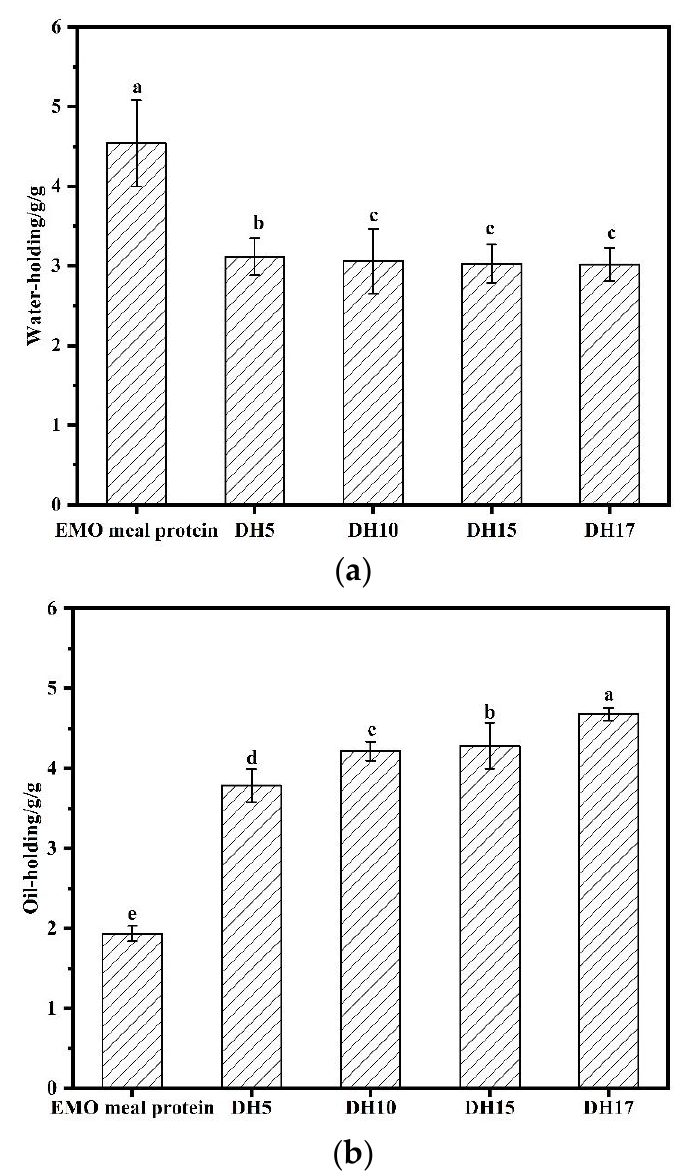
Figure 7. Water-holding capacity ( a ) and oil-holding capacity ( b ) of the EMO meal protein and hy- drolysates with different DH. The value of different superscript letters indicated significant difference ( p < 0.05).